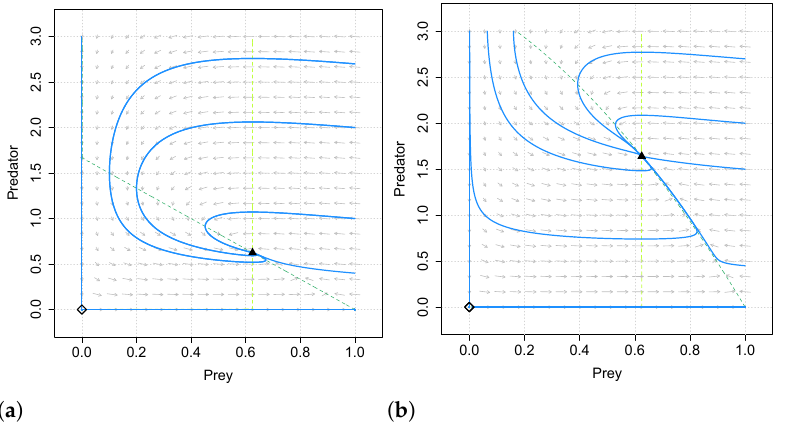
Figure 3. Dynamic behaviors with r = 2, n = 2, K = 1, m = − 2, q = 1.2, p = 0.8 and c = 0.5. ( a ) Coexistence in system (13). ( b ) Coexistence in system